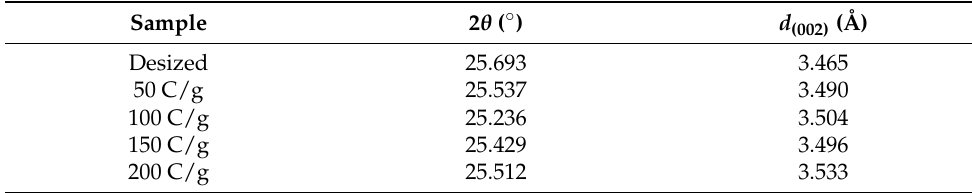
Table 2. Microstructure parameters of the (002) crystal plane of desized CFs and CFs treated with different EAO